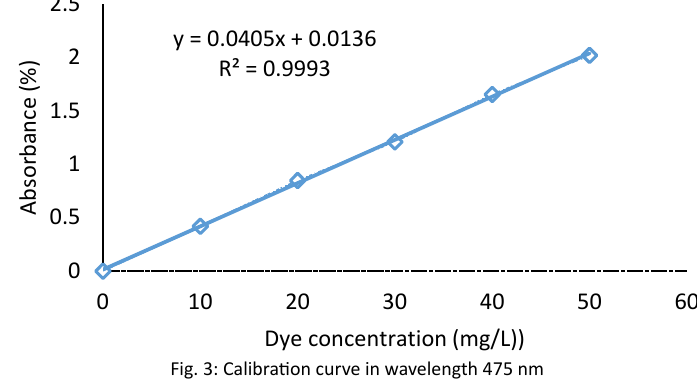
Fig. 3: Calibration curve in wavelength 475 nm Table 1: Experimental ranges and levels of independent variables for UV/TiO 2 process of AO10 removal Ranges and levels Independent variables